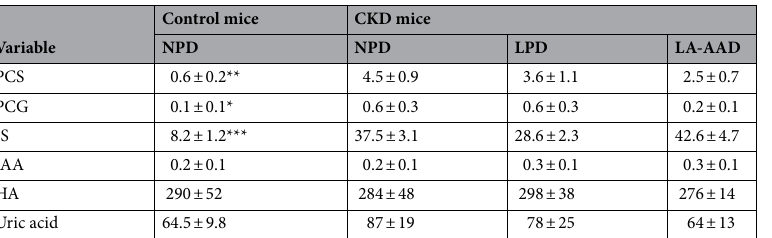
better understand the interaction with the intestinal microbiota and the host during CKD.